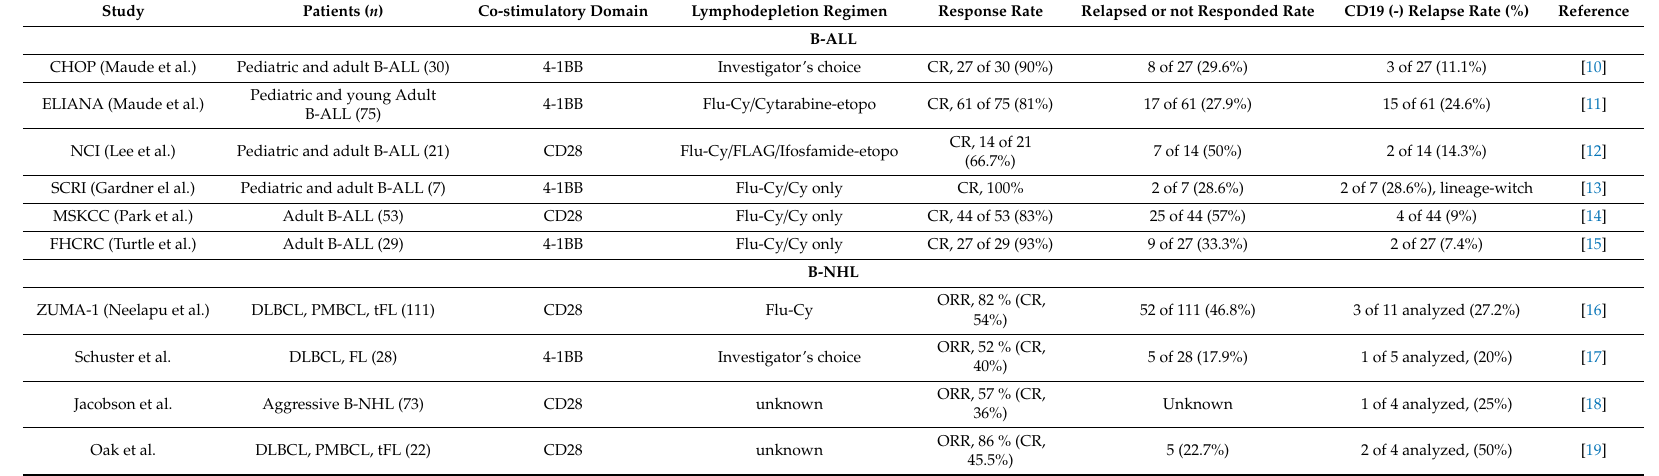
Table 1. Clinical data of CD19 chimeric antigen receptor (CAR) T-cell therapy in B-cell